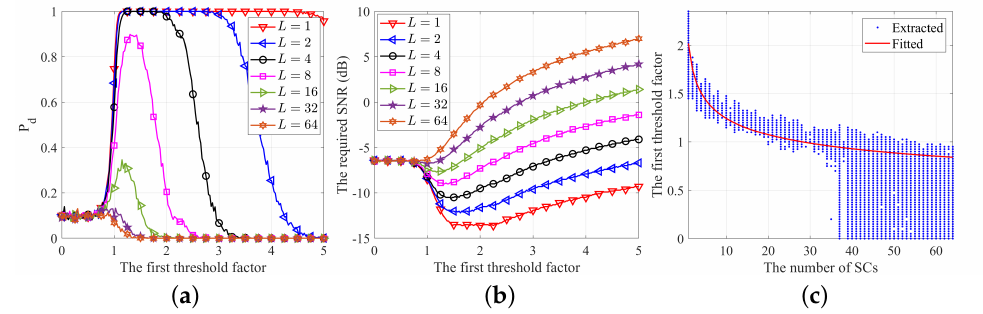
Figure 12. The relationship between the detection performances of DT-GRFT and DT-HGRFT and the first threshold, and the left column is the results of DT-GRFT, and the right column is the results of DT-HGRFT. ( a ) is P d curves of DT-HGRFT, when the SNR is − 9 dB. ( b ) is the required SNR curve of DT-HGRFT, when P d = 0.9. ( c ) is the fitted first threshold factor curve of DT-HGRFT.